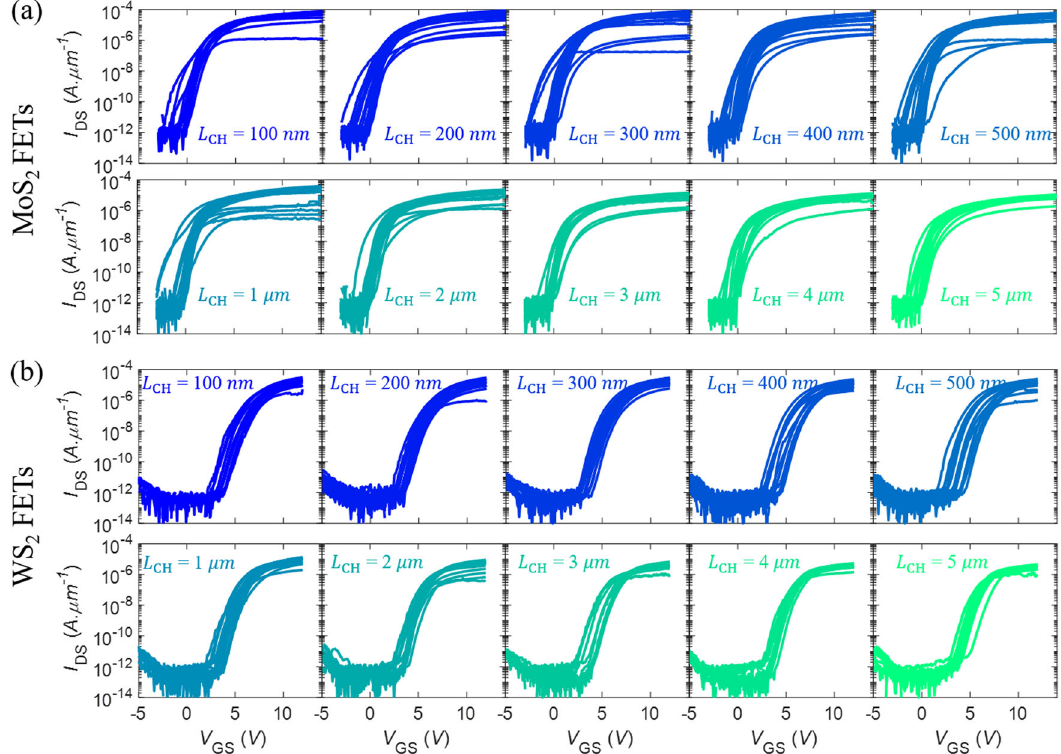
Fig. 3 Statistics of scaled devices. A total of 230 MoS 2 FETs and 160 WS 2 FETs were fabricated using 23 and 16 TLM structures with channel lengths ranging from L CH = 100 nm to L CH = 5 μ m for a MoS 2 and b WS 2 , respectively, to analyze the device-to-device variation and impact of scaling on the device performance. The corresponding transfer characteristics, i.e., I DS versus V GS , for V DS of 1 V are shown in the logarithmic scale.